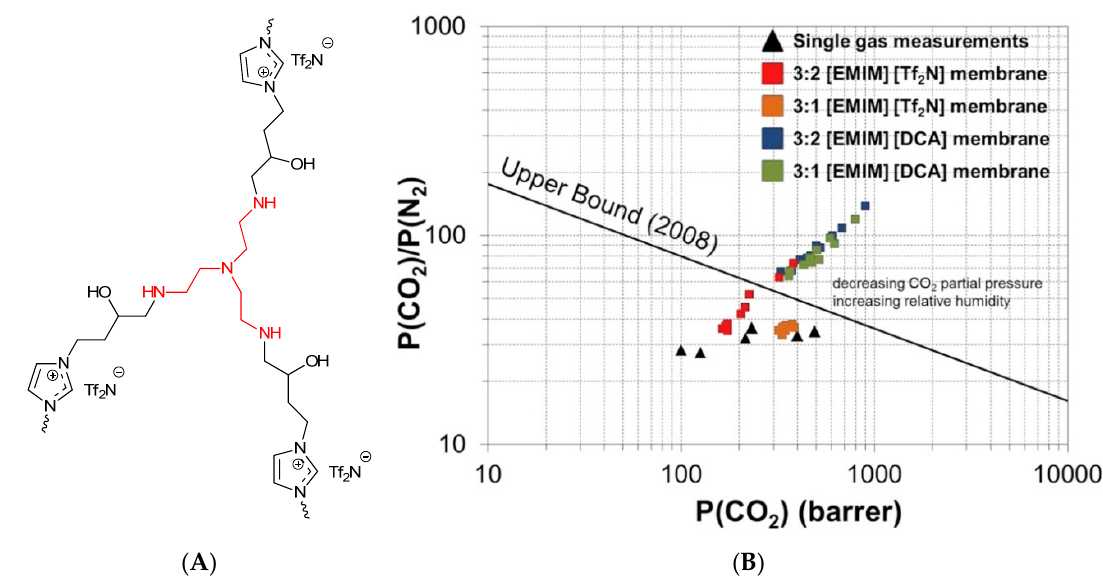
Figure 10. ( A ) Network structure for stoichiometry 3:1, assuming 100% conversion, and ( B ) CO 2 /N 2 Robeson plot (right) with data for epoxy-amine ion gels tested with single gases ( ▲ ) [145] and with humidified mixed-gas feeds ( □ ) [188], where the ratios 3:1 and 3:2 refer to the mole ratio of the epoxy monomer and the amine monomer. 1 Barrer = 10 − 10 cm 3STP cm cm − 2 s − 1 cmHg − 1 = 3.348 × 10 − 16 mol m m − 2 s − 1 Pa − 1 . Robeson plot reprinted from [188] . Copyright (2015), with permission from Elsevier.